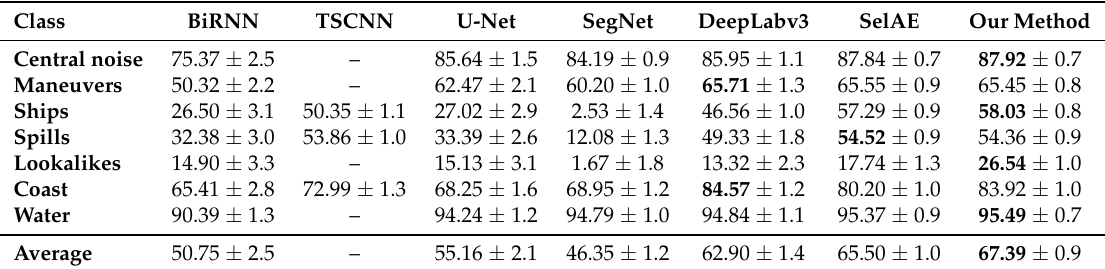
Table 5. Mean F 1 results of the 5-fold cross validation ( F 1 % ± σ ) obtained for each of the classes using the different methods evaluated. Best results per row are shown in